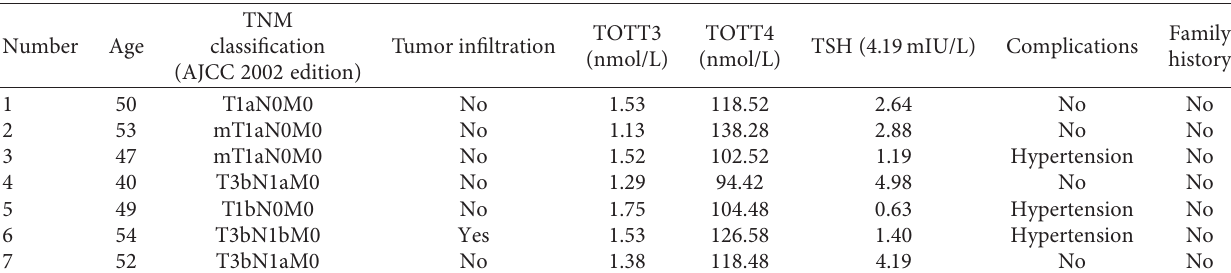
Table 1: Clinical information of 7 PTC